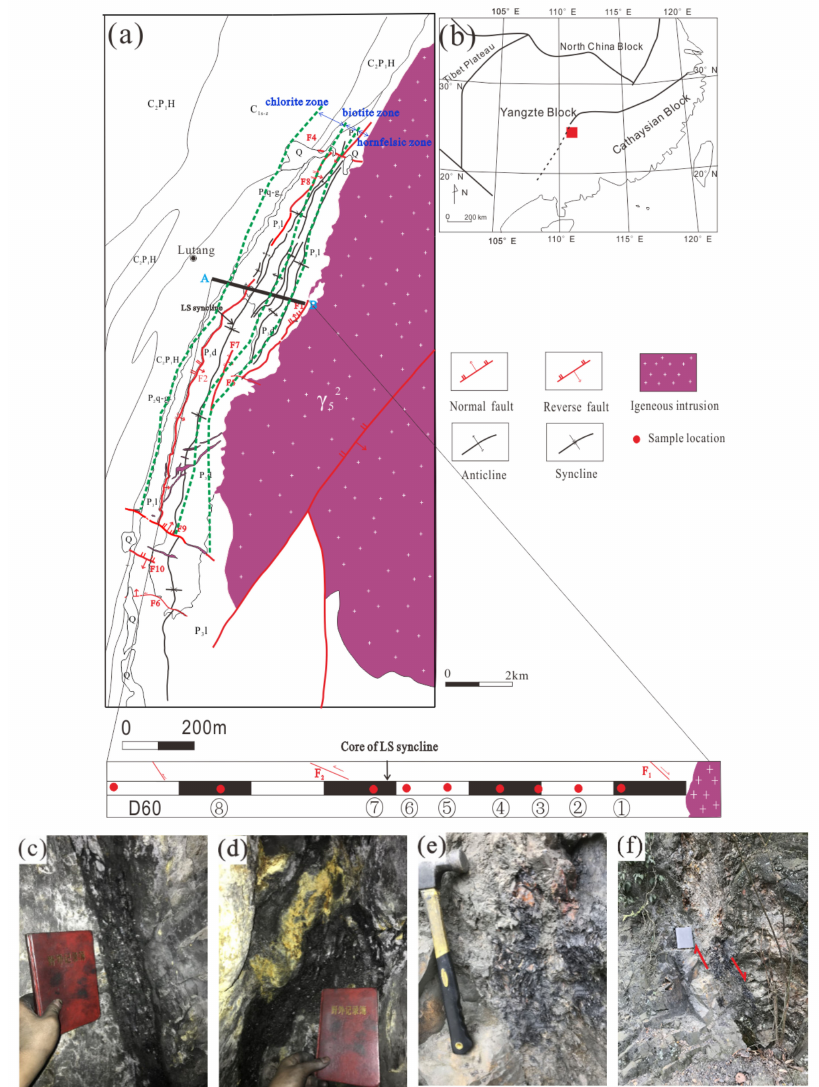
Figure 1. ( a ) Geological map of the research area and ( b ) location of the research area in China. Samples of the fourth group displayed di ff erent deformation characteristics at di ff erent tectonic locations: ( c ) brittle deformation and ( d ) ductile deformation, and ( e , f ) sample D60 exhibiting scaly flakes at the shear